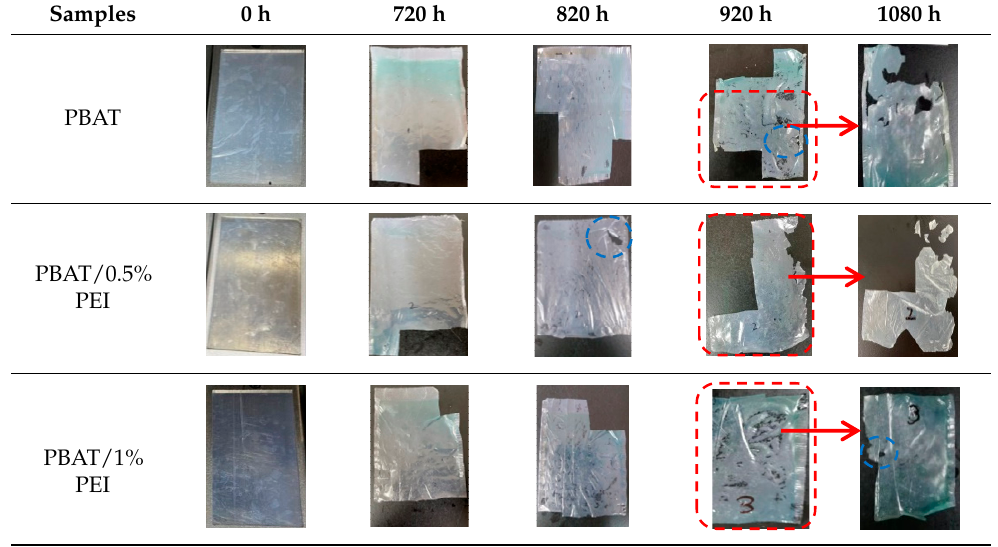
Table 6. Visual aspect of the samples during degradation in the Xenon lamp aging test machine.